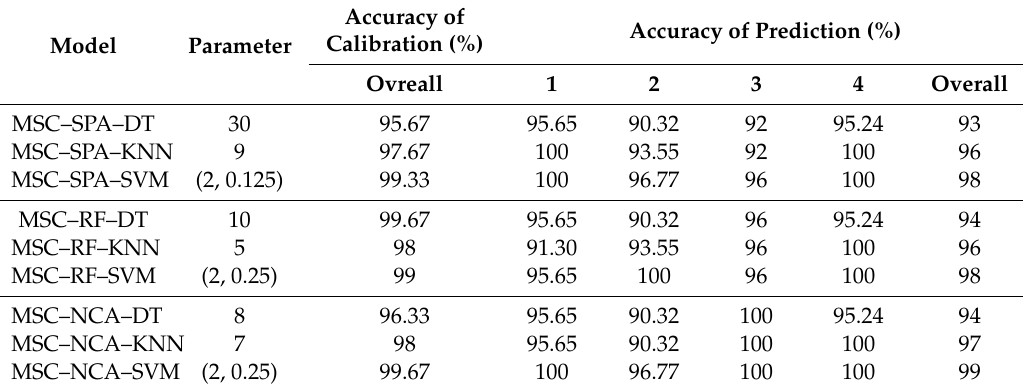
Table 2. Modeling analysis results based on characteristic